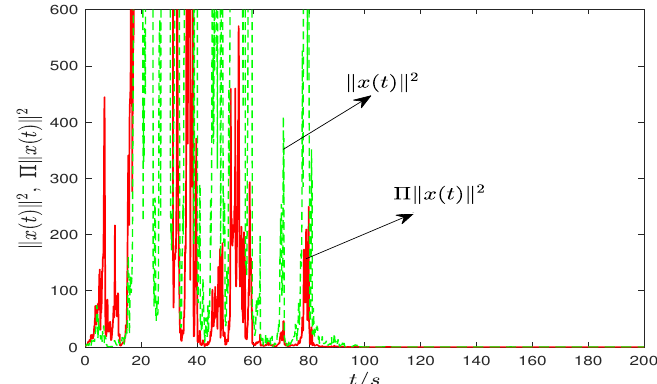
Figure 2. State trajectory curve of open-loop system